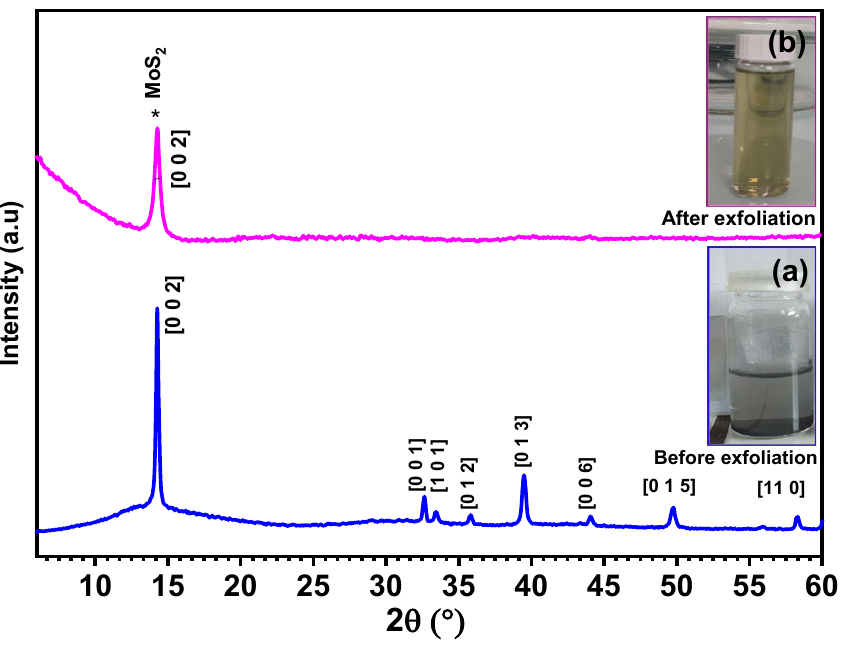
Figure 5. X-ray diffraction of MoS 2 commercial nanopowder ( a ) and after exfoliation ( b ). The inset figures represent dispersions ( a ) before and ( b ) after exfoliation.